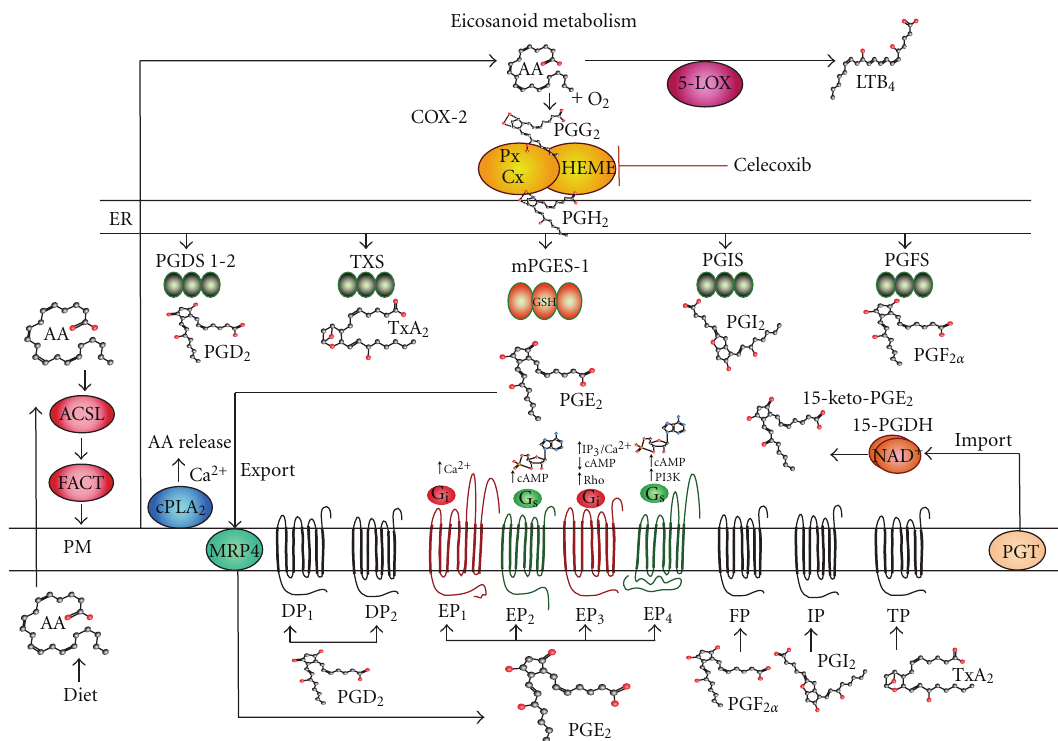
Figure 1: Eicosanoid metabolism. Arachidonic acid (AA) is an essential dietary fatty acid that is transported into cells and stored in membrane phospholipids. First AA is coupled to acyl-CoA by acyl-coenzyme A synthetases (ACLS). Fatty acyltransferases (FACT) then insert AA into membrane phospholipids. Cytoplasmic phospholipase A2 (cPLA2) releases AA from membrane phospholipids after agonist stimulation. In turn, free AA is converted to prostaglandin G 2 (PGG 2 ) and then prostaglandin H 2 (PGH 2 ) by cyclooxygenases (COXs). PGH 2 then becomes a substrate for a variety of PG synthases. These PG synthases are identified by the specific prostaglandin each one produces, namely, PGD 2 synthases (PGDSs), PGE 2 synthases (PGESs), (PGF 2 α ) synthase (PGFS), PGI 2 synthase (PGIS), or TxA 2 synthase (TXS). Both COX-2 and microsomal PGE synthase-1 (mPGES-1) are elevated in tumors. Export involves multidrug resistance-associated protein 4 (MRP4). In the extracellular milieu, PGs bind to G-protein-coupled receptors identified as DP1, DP2, EP1-4, FP, IP, and TP. Among these, EP receptors interact with G-stimulatory (Gs) or G-inhibitory (Gi) proteins stimulating downstream signals such as cAMP, Ca 2+ , inositol phosphates or IP3/Ca 2+ , and Rho. Catabolism involves uptake by PG transporter (PGT) and inactivation by NAD+ dependent 15-hydroxyprostaglandin dehydrogenase